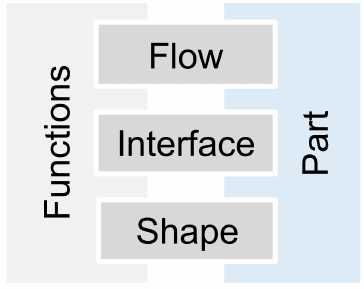
Figure 6. Elements characterizing a